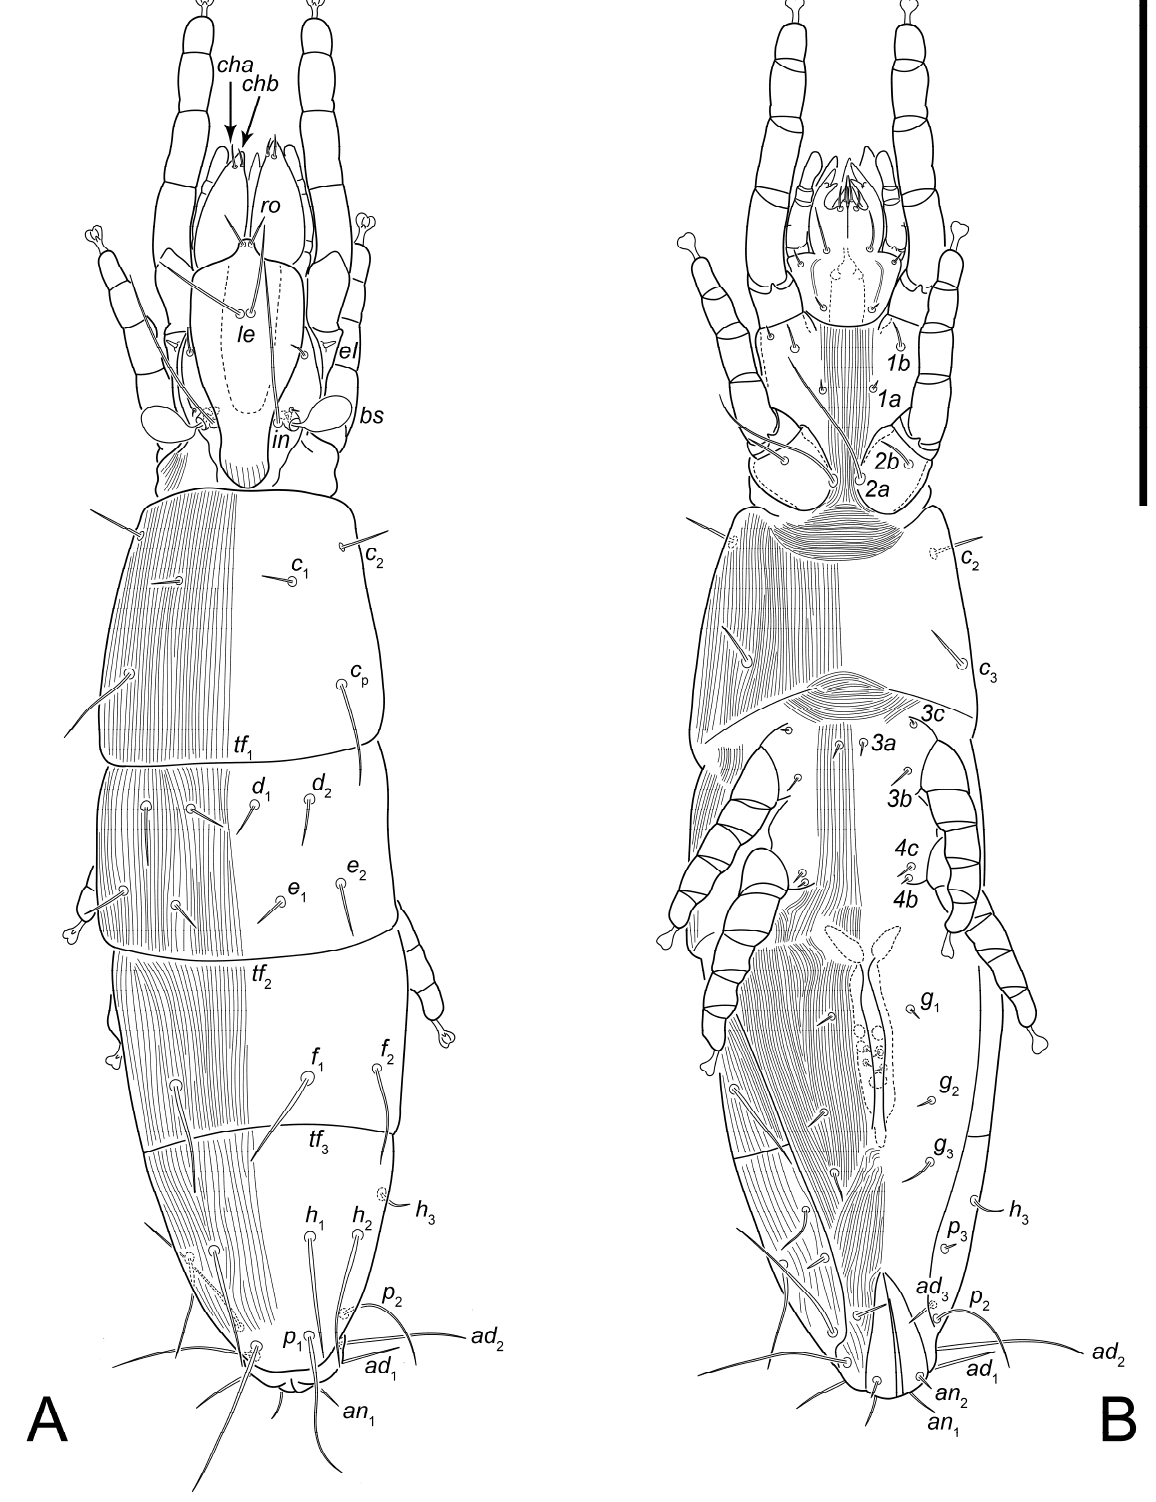
Figure 3. Paralycus daeira sp. n., female: ( A )—dorsal view; ( B )—ventral view. Scale bar 100 µm.